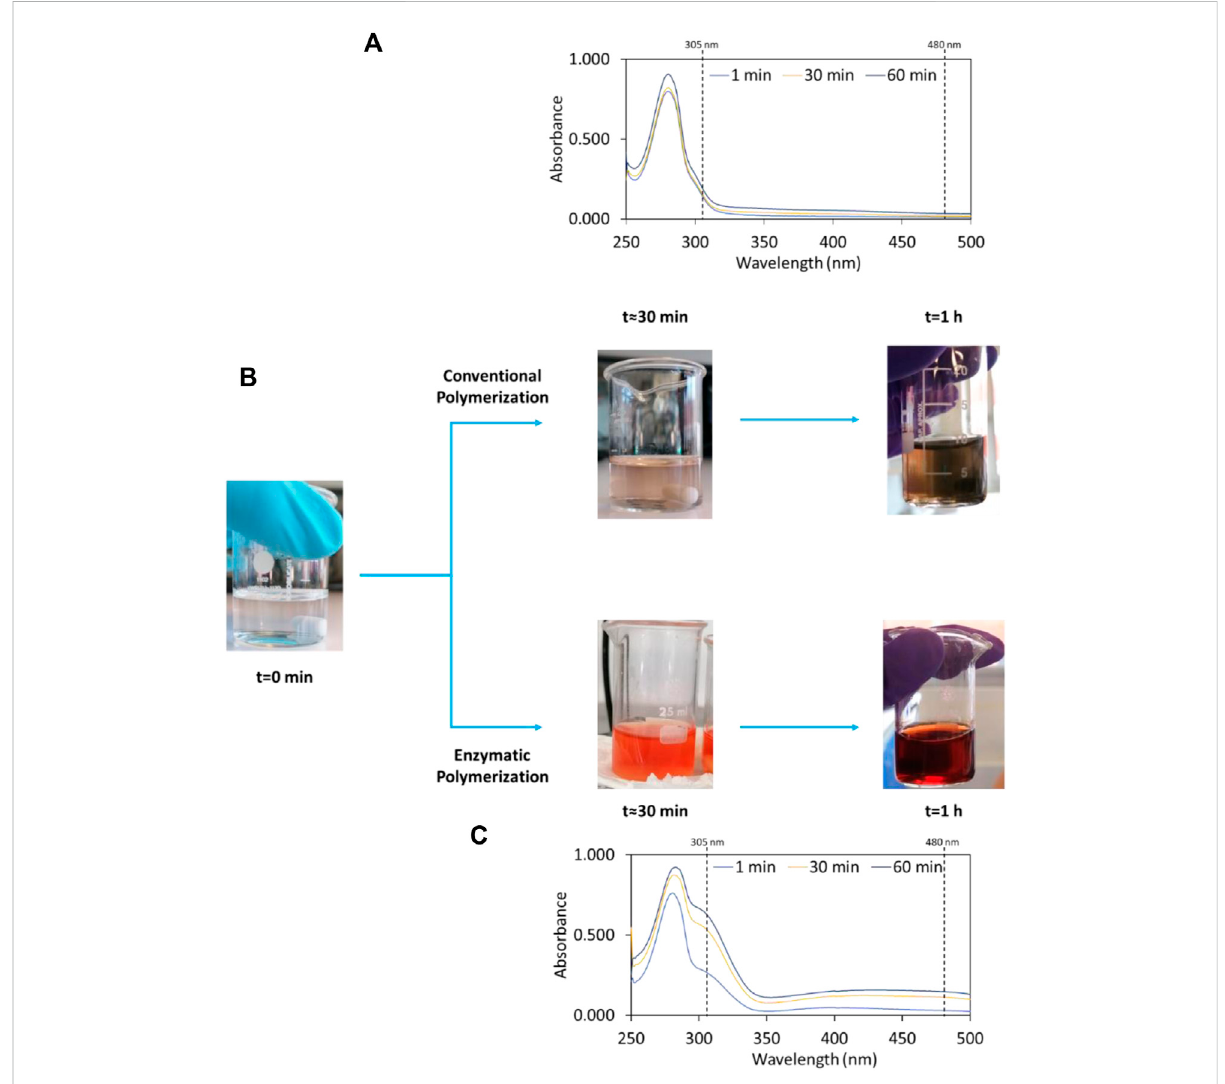
FIGURE 1 Colour changes of initial solutions of dopamine after 30 min and 1 h (B) and time-dependent UV-Vis absorbance spectra for: Conventional polymerization of dopamine, pH 8.5 and 30 ° C (A) and enzymatic polymerization of dopamine, pH 5.5 and 30 ° C (C)